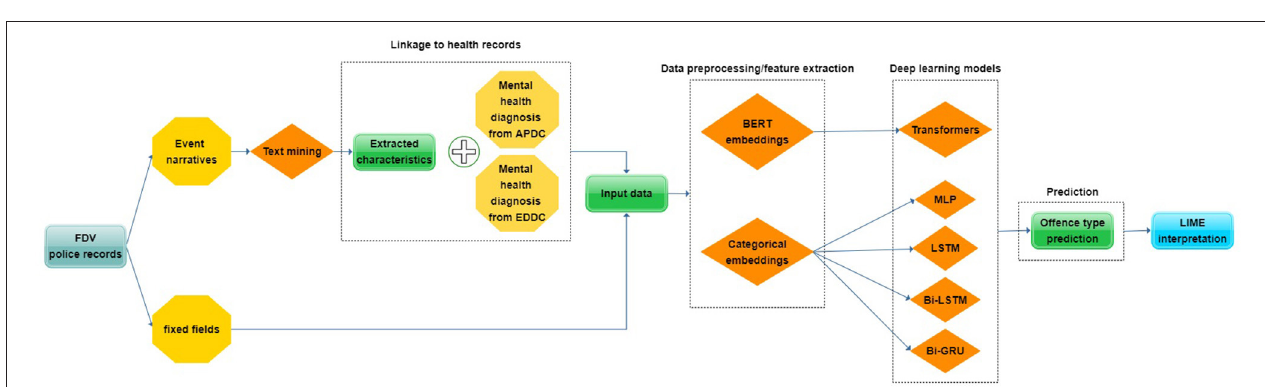
FIGURE 6 | An overview of the methodology used to predict three FDV offense types utilizing a combination of different data sources through a previously used text mining approach, linkage to health records and five deep learning models.